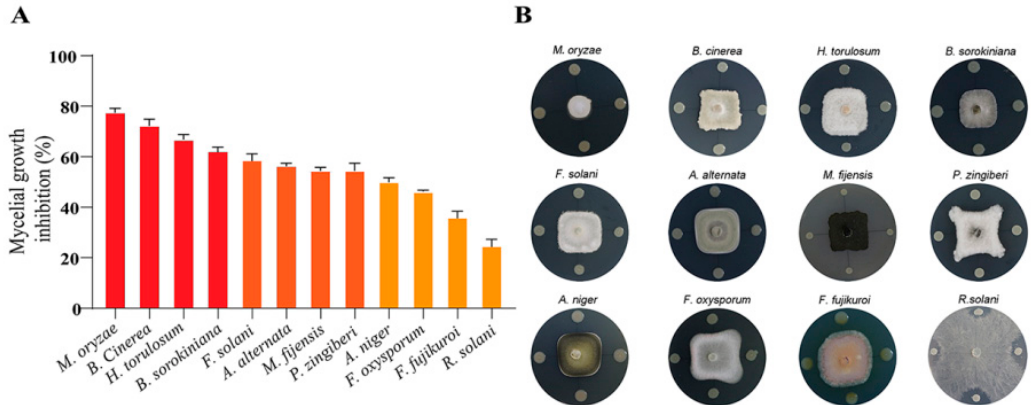
Figure 2. In vitro antagonism of strain ETR-B22 against 12 plant fungal pathogens using dual culture method. ( A ) Percentage of inhibition of fungal pathogens. Values represent the average of three replicates ± standard error. ( B ) Antagonism test between strain ETR-B22 and fungal pathogens.